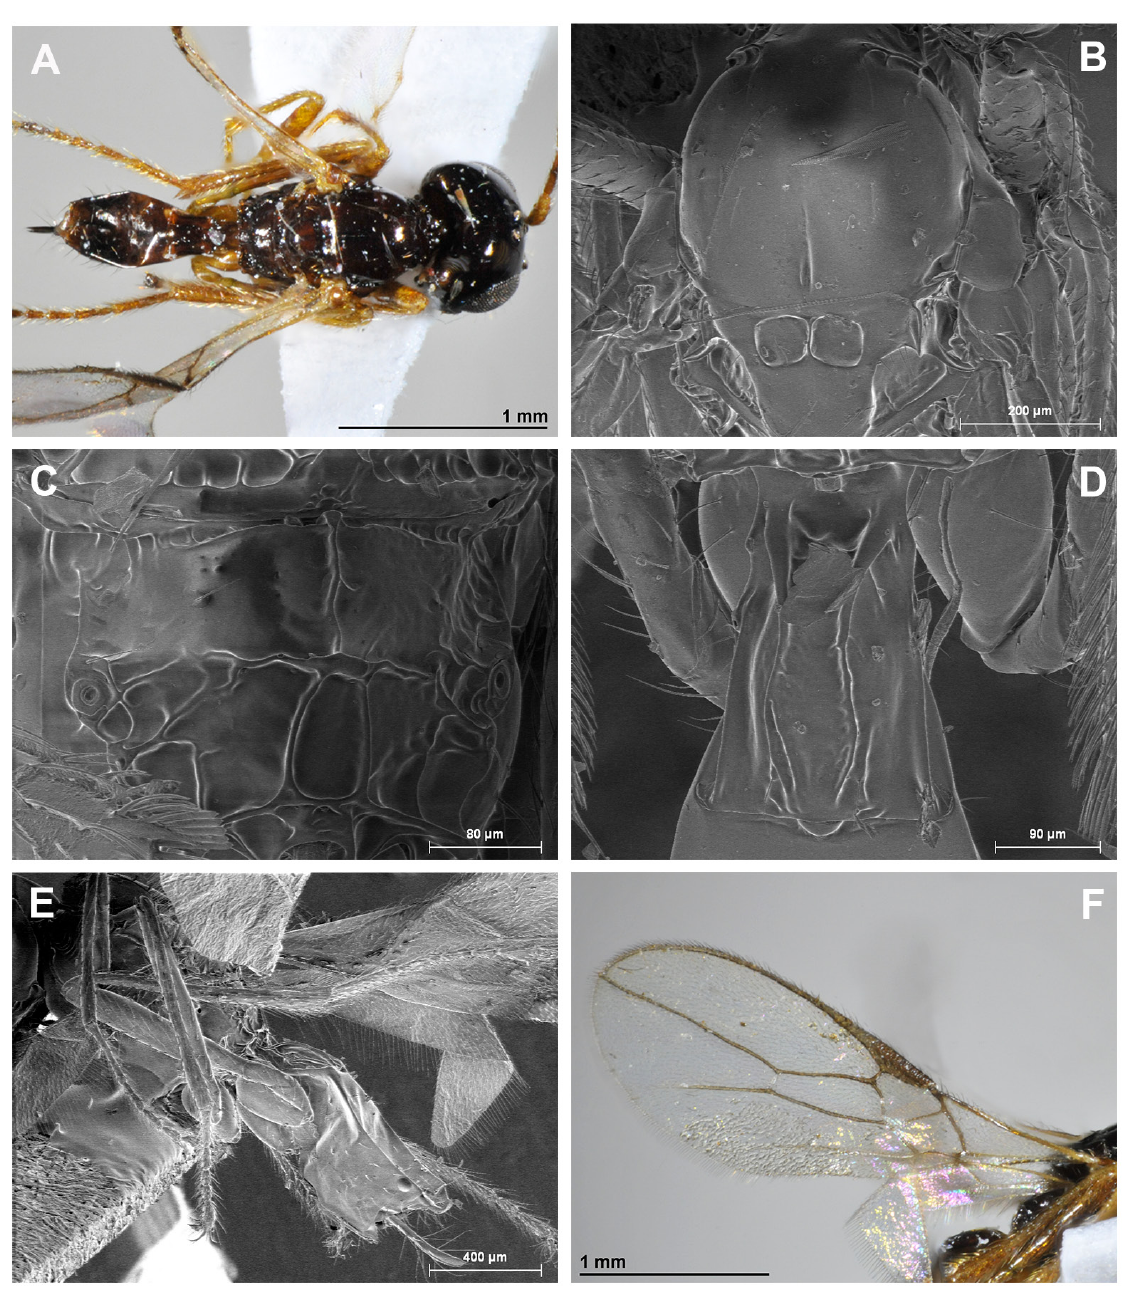
Fig. 65. Asobara transversaria Fischer, 2007, ♀, holotype (OLML). A . Habitus, dorsal view. B . Mesoscutum, dorsal view. C . Propodeum. D . First metasomal tergite, dorsal view. E . Hind leg, metasoma and ovipositor, lateral view. F . Fore